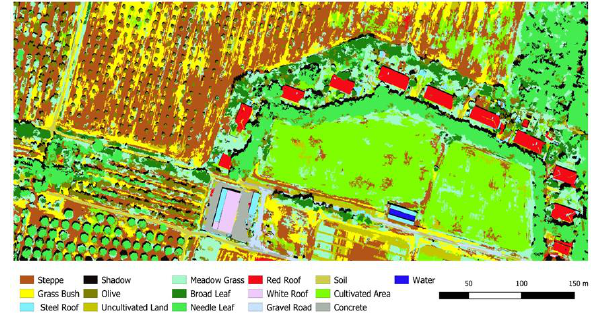
Figure 5 . Nearest neighbour object-based classification map The results demonstrated that the orthomosaic derived from DJI Phantom IV multispectral UAV has more than 90% accuracy both for pixel-based and object-based land cover